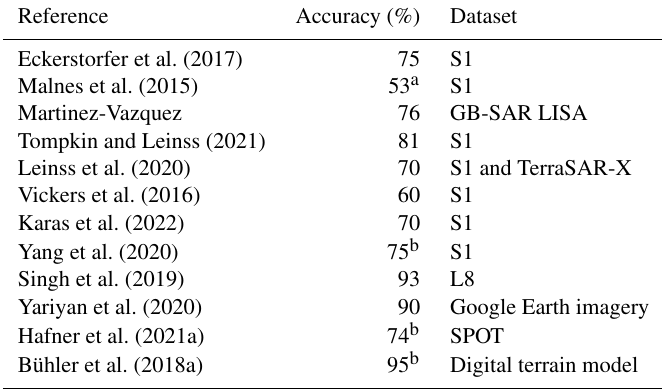
Table 4. References on snow avalanche accuracy using remote sensing products (radar, optical, and terrain). S1 signifies Sentinel-1, L8 Landsat-8, and GB-SAR LISA ground-based synthetic aperture radar linear